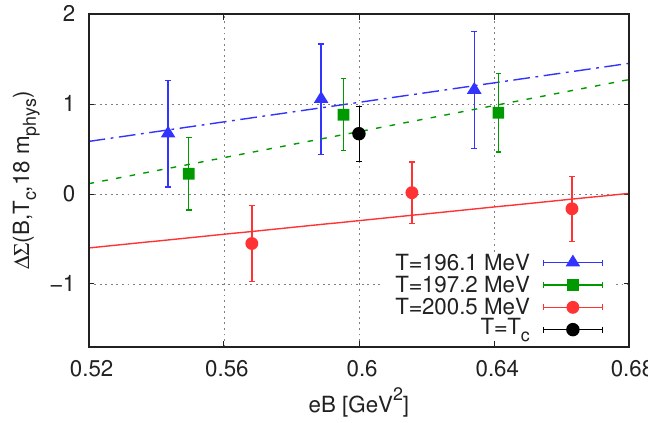
Figure 4 . Visualization of our interpolation scheme for m=m phys = 18. The pseudo-critical temperature is T c = 197 : 3(5) MeV. The lines indicate the results of the interpolation in B to eB 0 = 0 : 6 GeV 2 at a (cid:12)xed temperature, and the black (cid:12)lled circle represents the result of the (cid:12)nal interpolation in the temperature.